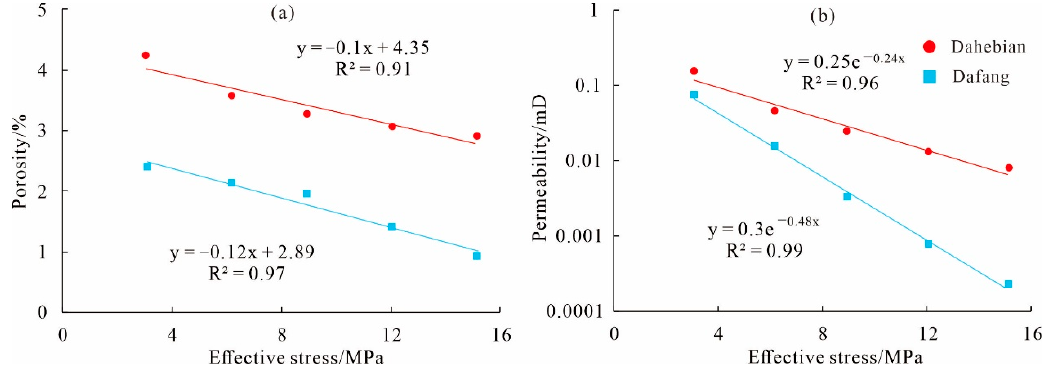
Figure 7. Relationship between effective stress with porosity ( a ) and permeability ( b ).